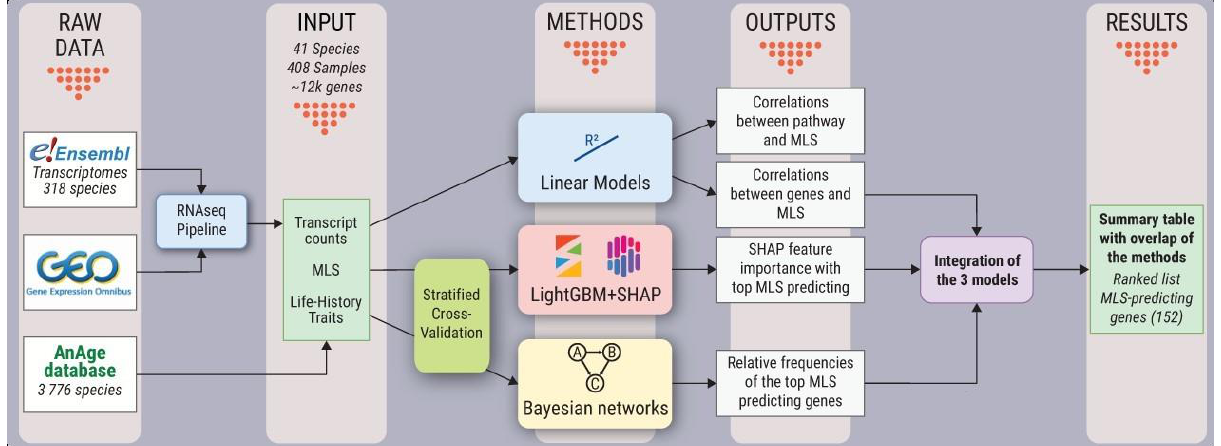
Figure 1. Schematic representation of the analysis workflow used in this study.